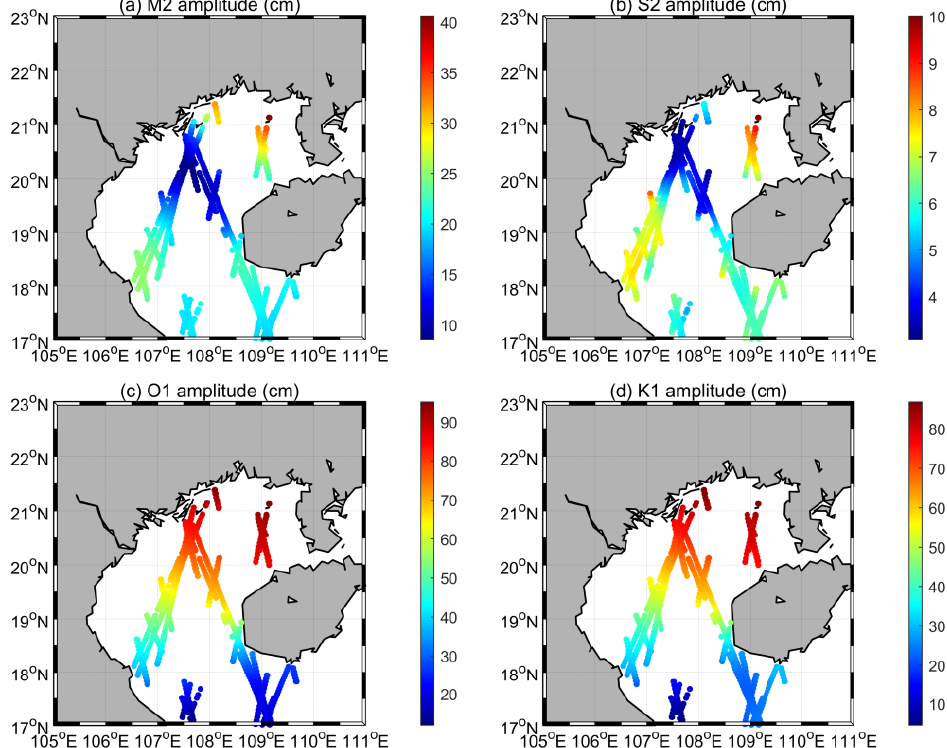
Figure 6. Estimated tidal amplitudes (unit: cm) in the Gulf of Tonkin from multi-satellite altimeter observations ( a ) M 2 ( b ) S 2 ( c ) O 1 ( d ) K 1 .